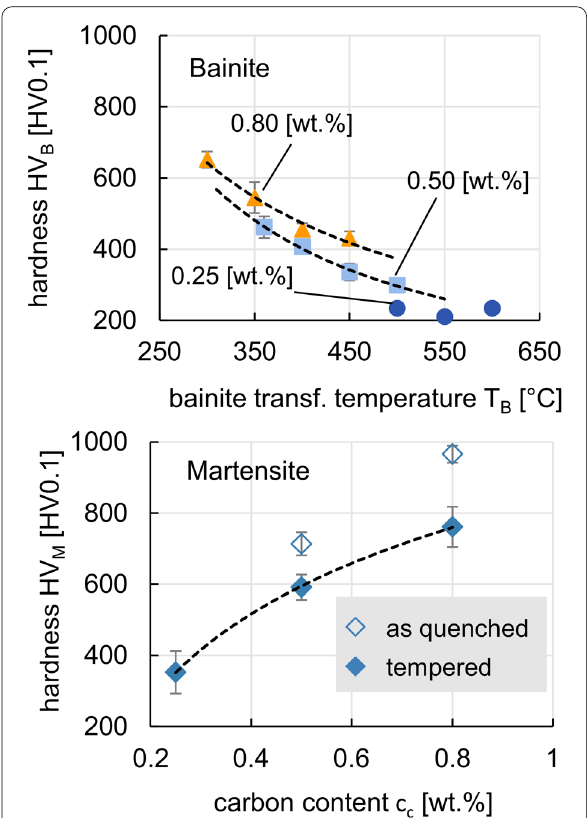
Figure 6 Measurement of hardness on dilatometer samples with bainitic and martensitic microstructures